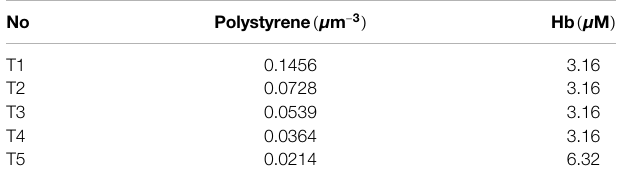
Figure 3 . Since iterative curve fi tting results highly depend on initial values of target parameters, we generated a database of diffuse re fl ectance spectra using uniformly sampled values of the target parameters. Each set of target spectra, simulated ( Section 2.4 ) or experimentally measured, was compared to the database to select fi ve sets of target parameters that resulted in the smallest spectral errors. Iterative curve fi tting was performed fi ve times using the fi ve sets of parameters from the database as initial values. The fi tting results with the smallest root-mean-square spectral error was taken as the extracted optical parameters.